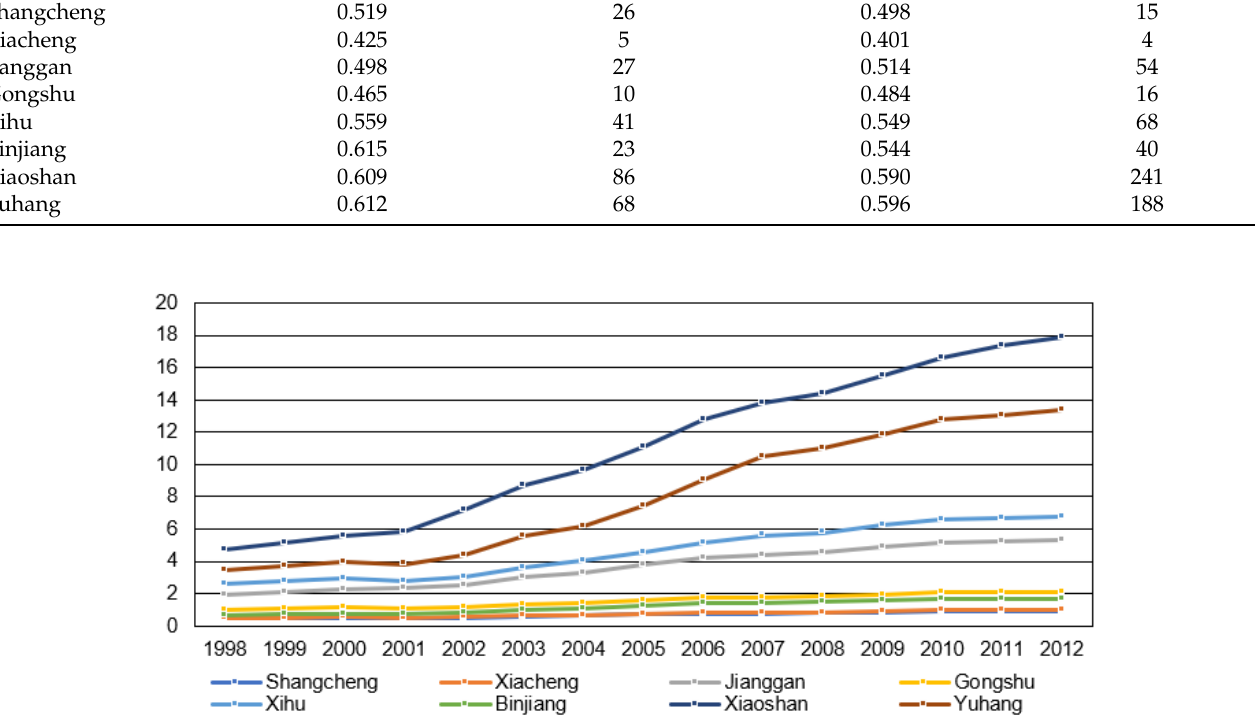
Figure 8. CO 2 emissions in each district from 1998 to 2012 (million tons).